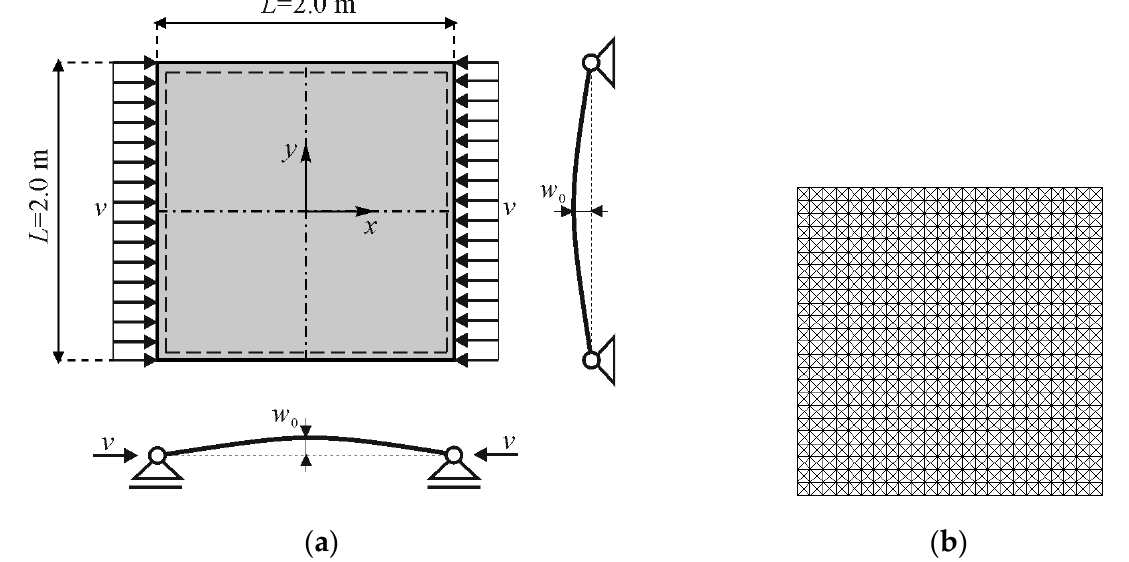
Figure 22. Rectangular plate exposed to axial loading: ( a ) geometry and loading condition; ( b ) finite element mesh. The discretisation of the plate with the FE mesh is presented in Figure 22b. The thickness of the plate was 20 mm. In order to account for some extent of imperfection, the initial deflection of the plate was adopted as the cosine function: